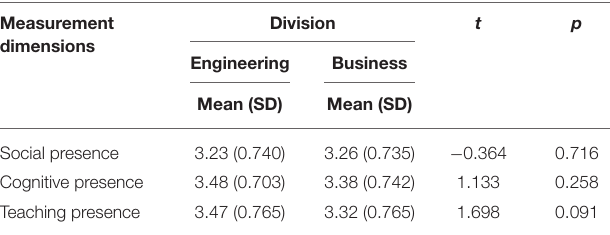
TABLE 6 | The statistical analysis of each CoI measurement dimension between engineering and business